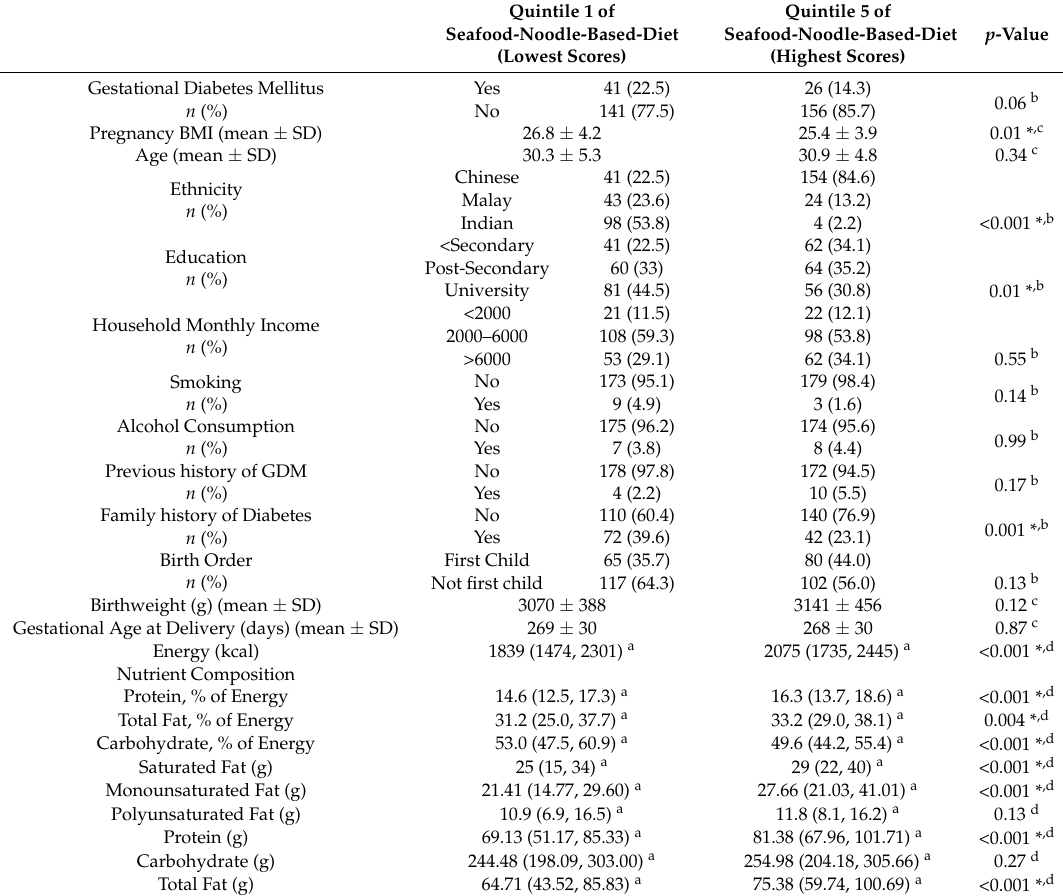
Table 3. Participant characteristics and nutrient composition by quintile of seafood-noodle-based-diet.